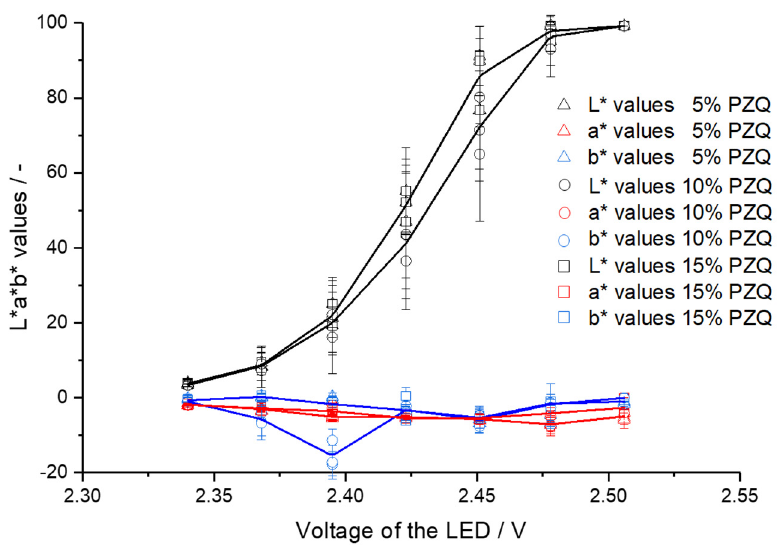
Figure 7. L*a*b* values depending on LED voltage for VA-5% PZQ, VA-10% PZQ, and VA-15% PZQ filaments (mean ± SD, each of the three filaments, n = 6).